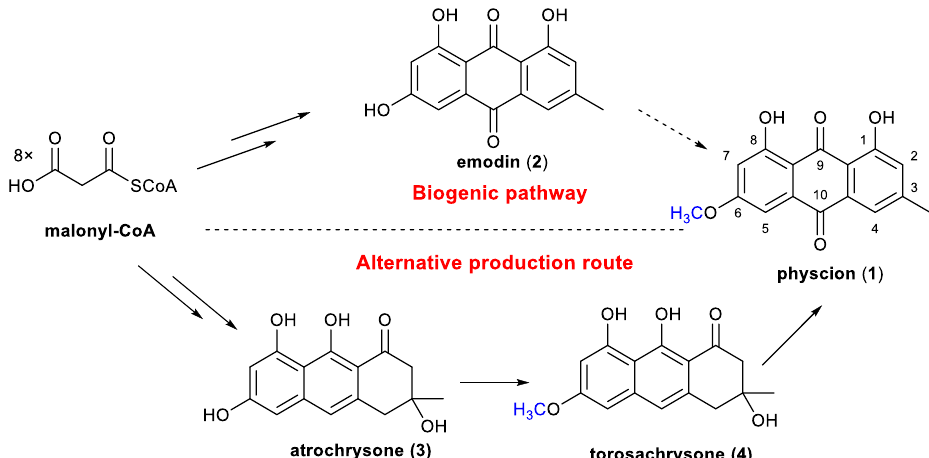
Fig. 1 Putative biogenic pathway of anthraquinone fungicide physcion and the alternative production route developed in this